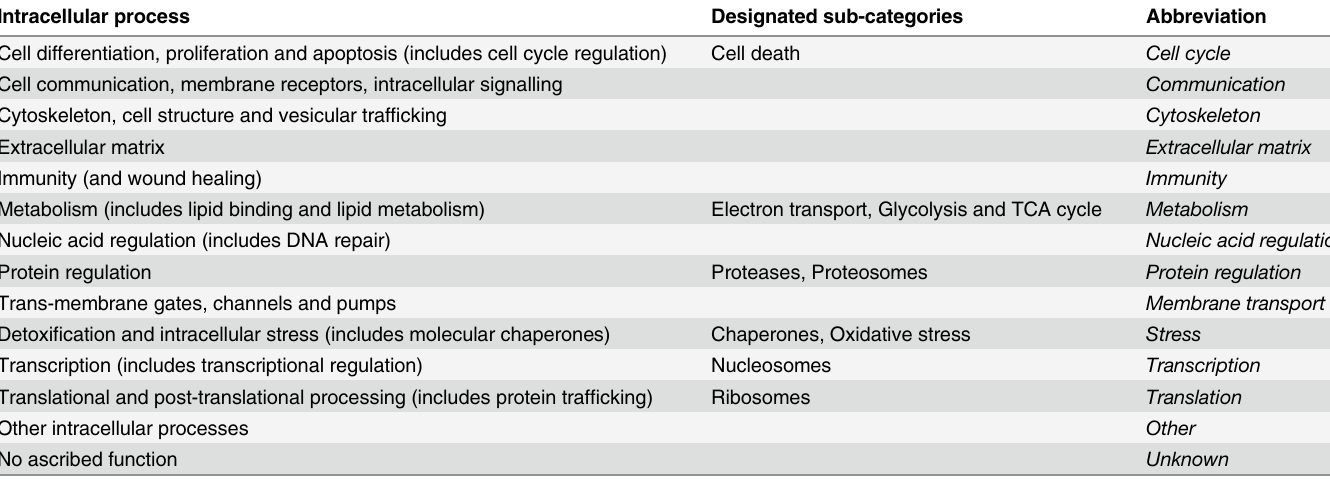
Table 3. Abbreviations assigned to the twelve functional gene categories that were affected by environmental